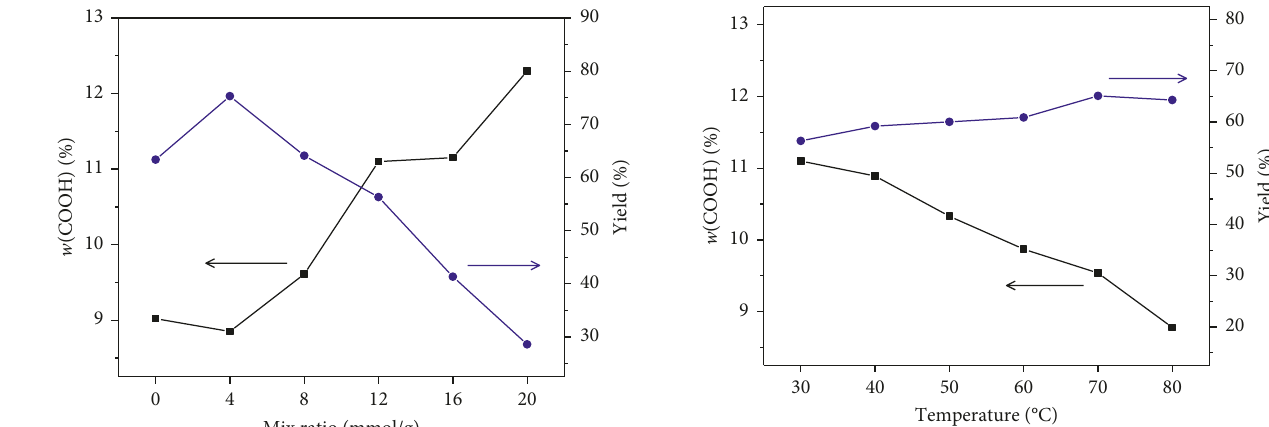
Figure 1: Effect of the mix ratio on the yield and the content of carboxyl of LPCAs.